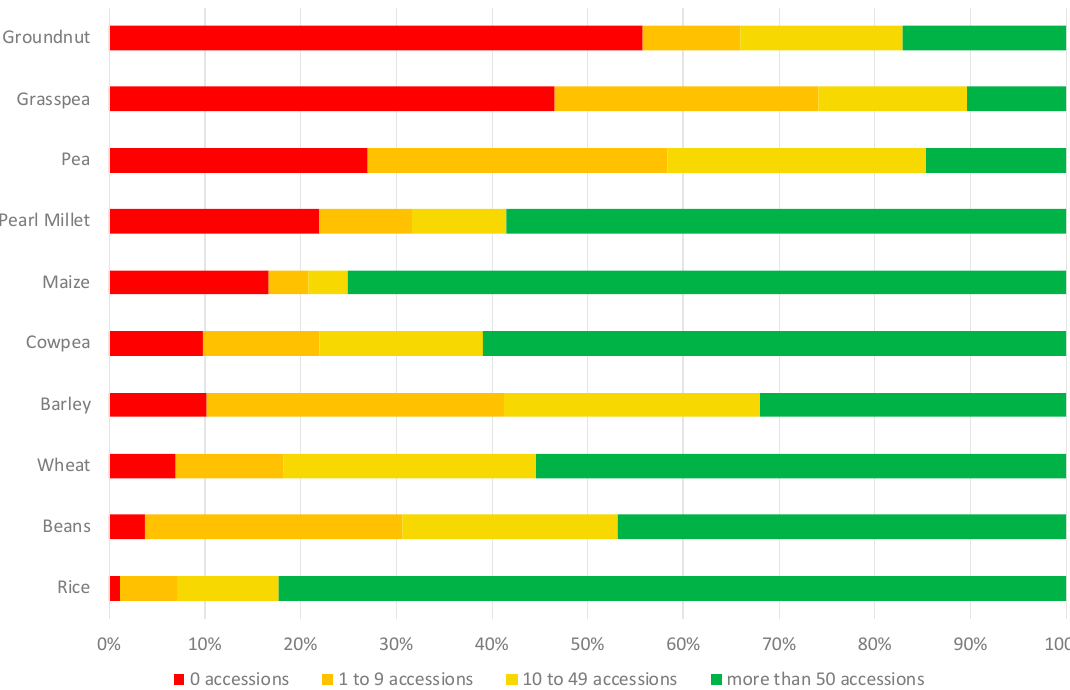
Figure 6. Preliminary assessment of the coverage of traditional landraces in international collections managed by CGIAR Centers. Note: these findings were generated by mapping accessions onto diversity trees. The colors correspond to numbers of accessions representing identified landrace end-groups or varieties making up the crop gene pool. This figure is reproduced from the 2019 Annual Report of the CGIAR Genebank Platform [40].